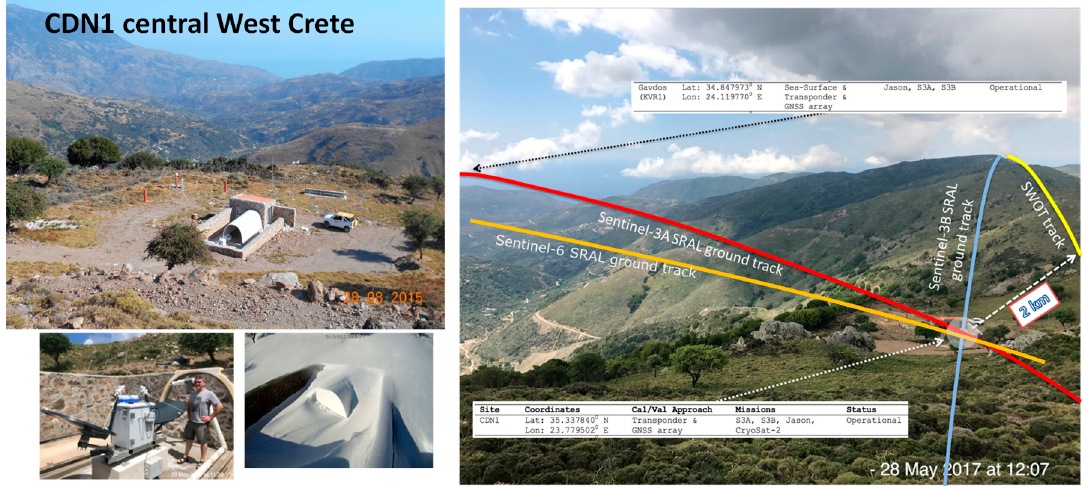
Figure 20. The CDN1 transponder calibration site in West Crete Mountains.